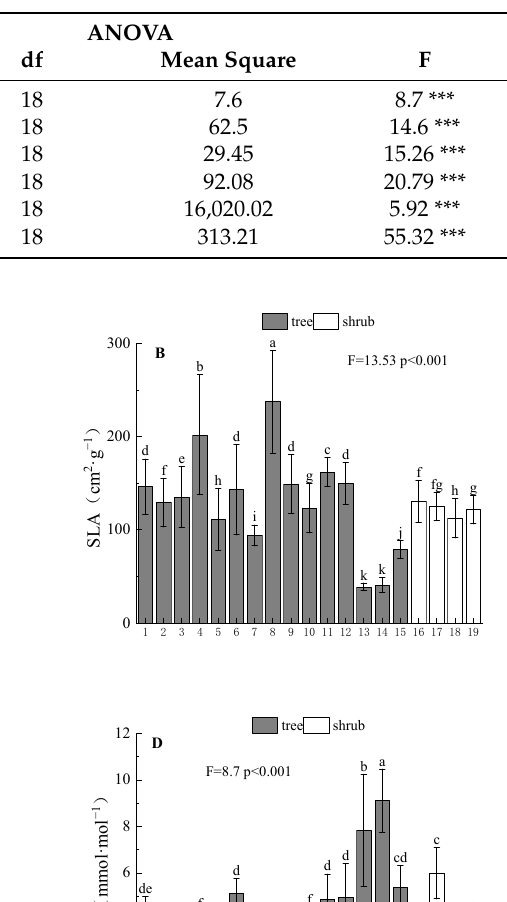
tree shrub F=14.74 p<0.001